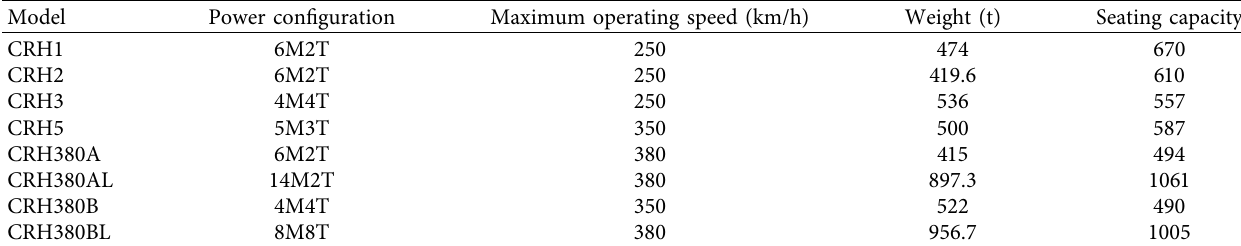
Table 1: Technical specifications of typical EMUs.